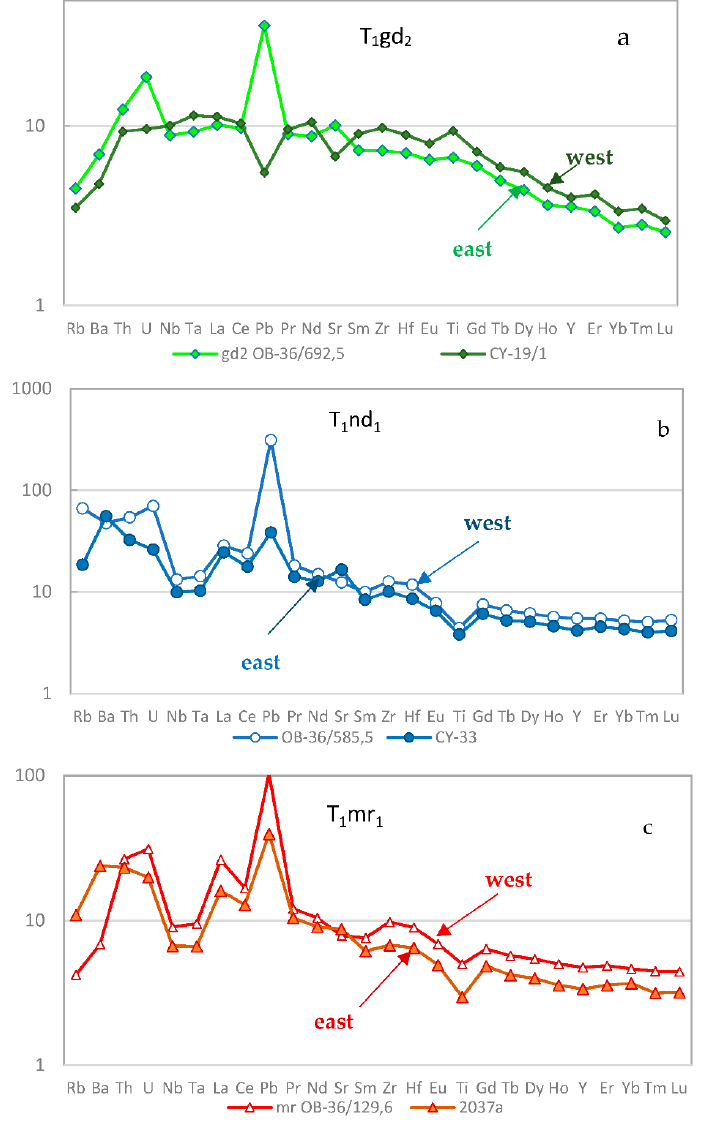
Figure 21. Patterns for rocks from the west and east parts of the Norilsk area; Gudchikinsky picrits ( a ), Nadezhadinsky ( b ) and Morongovsky ( c ) basalts.